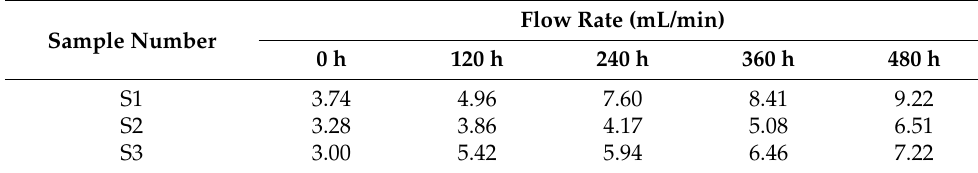
Table 3. Experimental results of flow rate.